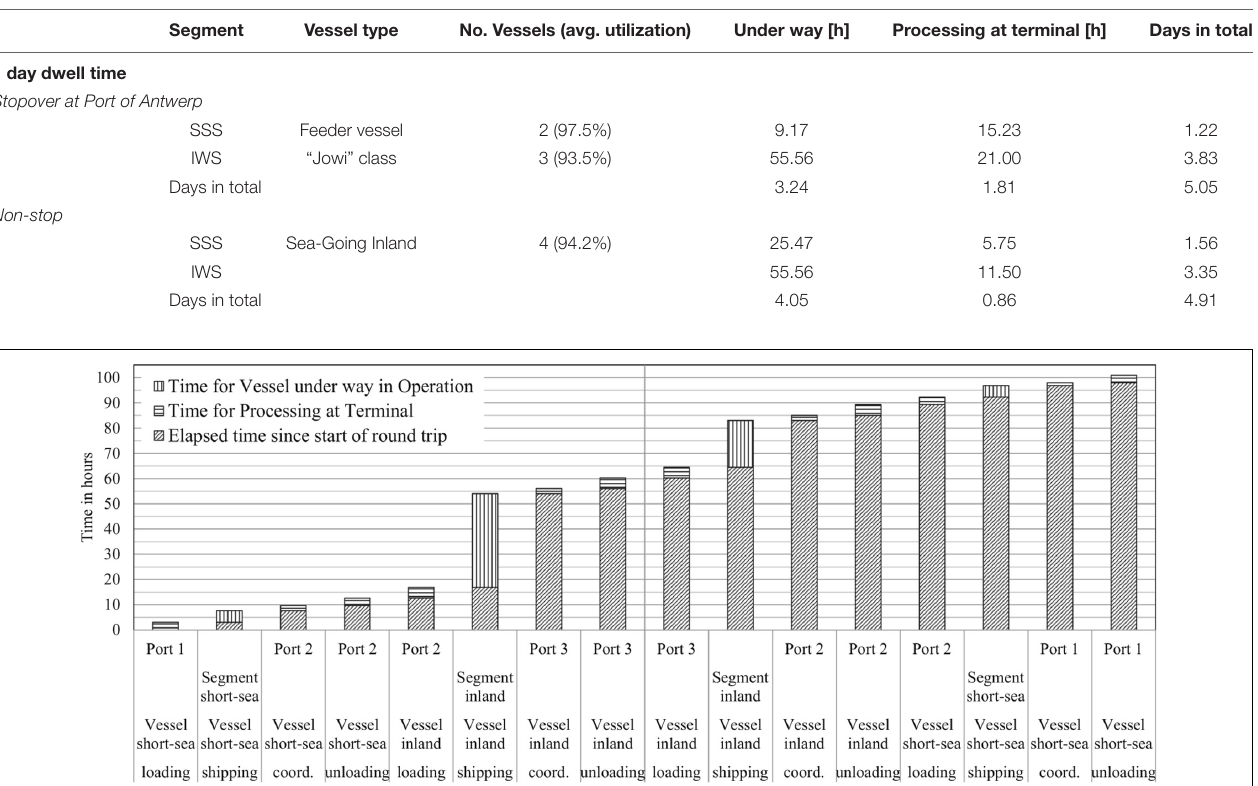
TABLE 8 | Round trip durations per vessel for the hinterland connection transport and logistics hub – NRW insteady-state scenario with stopover at the Port of Antwerp and with non-stop solution, adapted from (Assbrock et al., 2020).